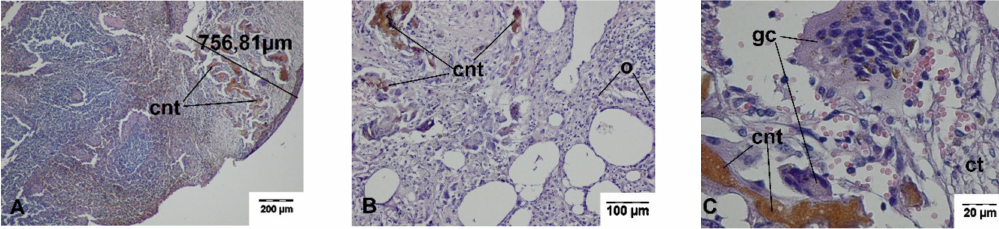
Figure 7. Histopathological sections of the spleen 14 days following cutting with the thulium-doped fiber laser (TDFL) (HE-staining). Black lines indicate the width of the entire zone of thermal damage. ( A ) A narrow streak of the residues of carbonized tissue in the cortex of the spleen (magnification × 40); ( B ) site of omentum adhesion to the spleen (magnification × 100); ( C ) multinucleated giant cells adjacent to the residues of carbonized tissue (magnification × 400). cnt, carbonized necrotic tissue; o, omentum; gc, giant cells; ct, connective tissue.